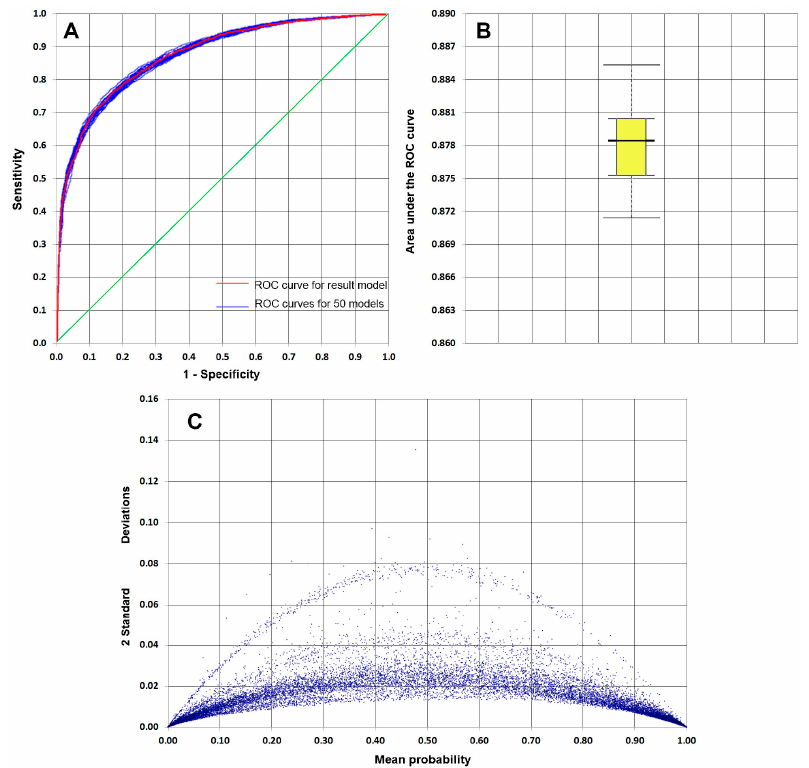
Figure 6. ( A ) Receiver operating characteristic (ROC) curve for the logistic model; ( B ) sensitivity analysis with validation dataset for 50 desertification susceptibility estimates; and ( C ) desertification susceptibility model error. The x -axis shows the mean value of 50 probability estimates; the y -axis represents two standard deviations of the probability